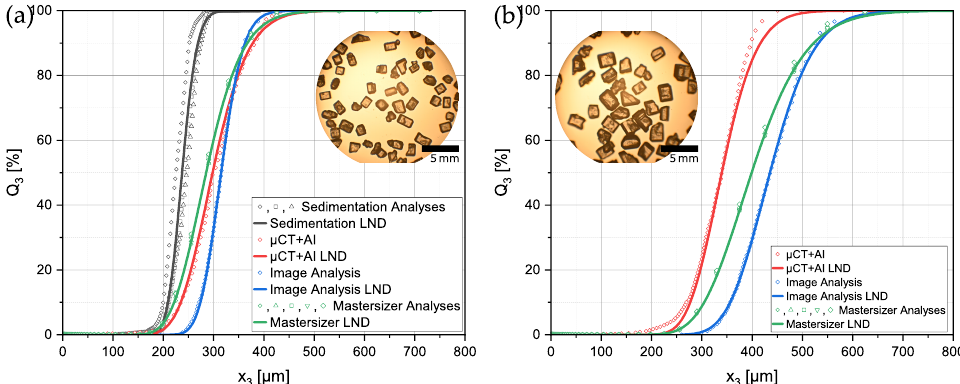
Figure 7. Volumetric particle size distributions measured with different strategies of the sieve size fractions: ( a ) Sucrose 180–250µm, ( b ) Sucrose 250–400µm. A lognormal distribution (LND) was fitted to each of the raw